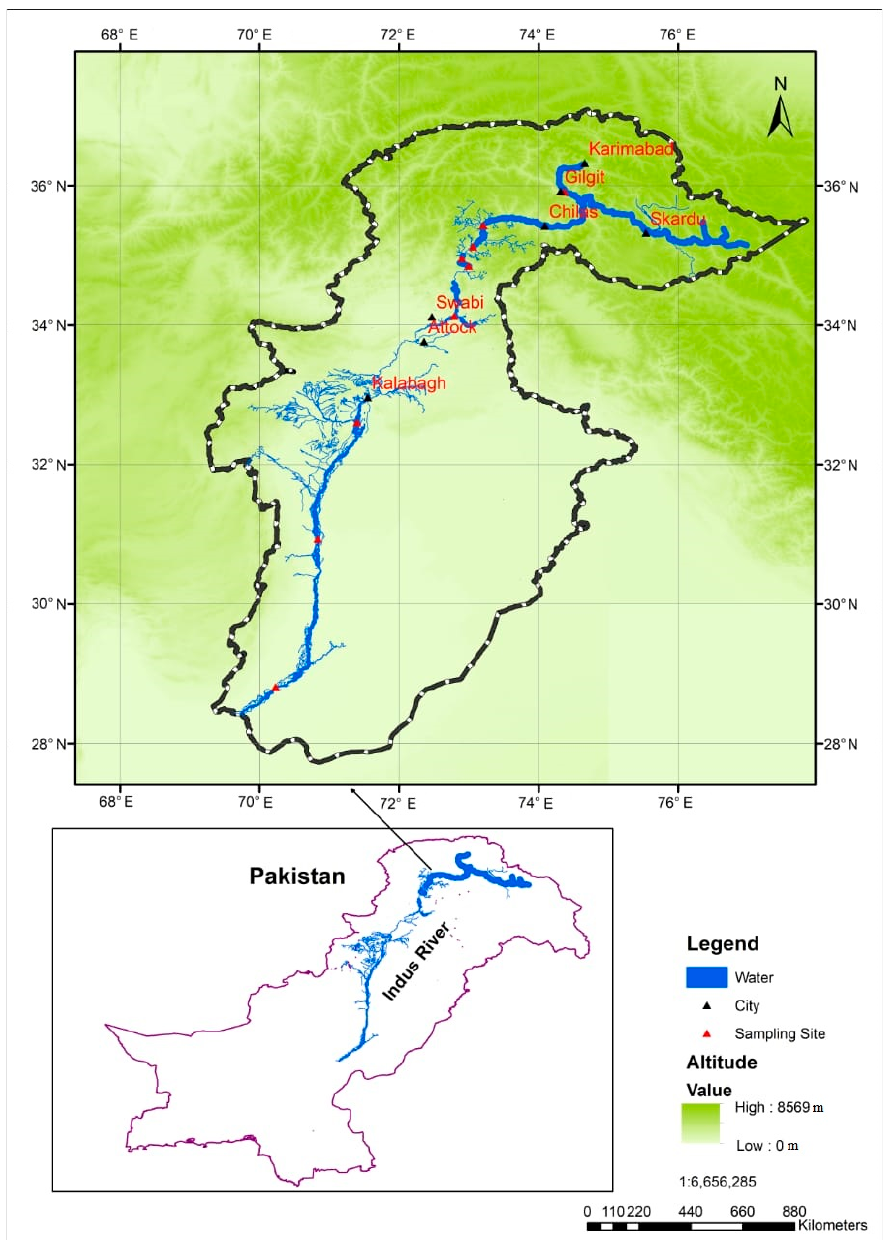
Figure 1. Location of sample sites in the upper and lower Indus basin riparian zones of the Indus River in Pakistan.